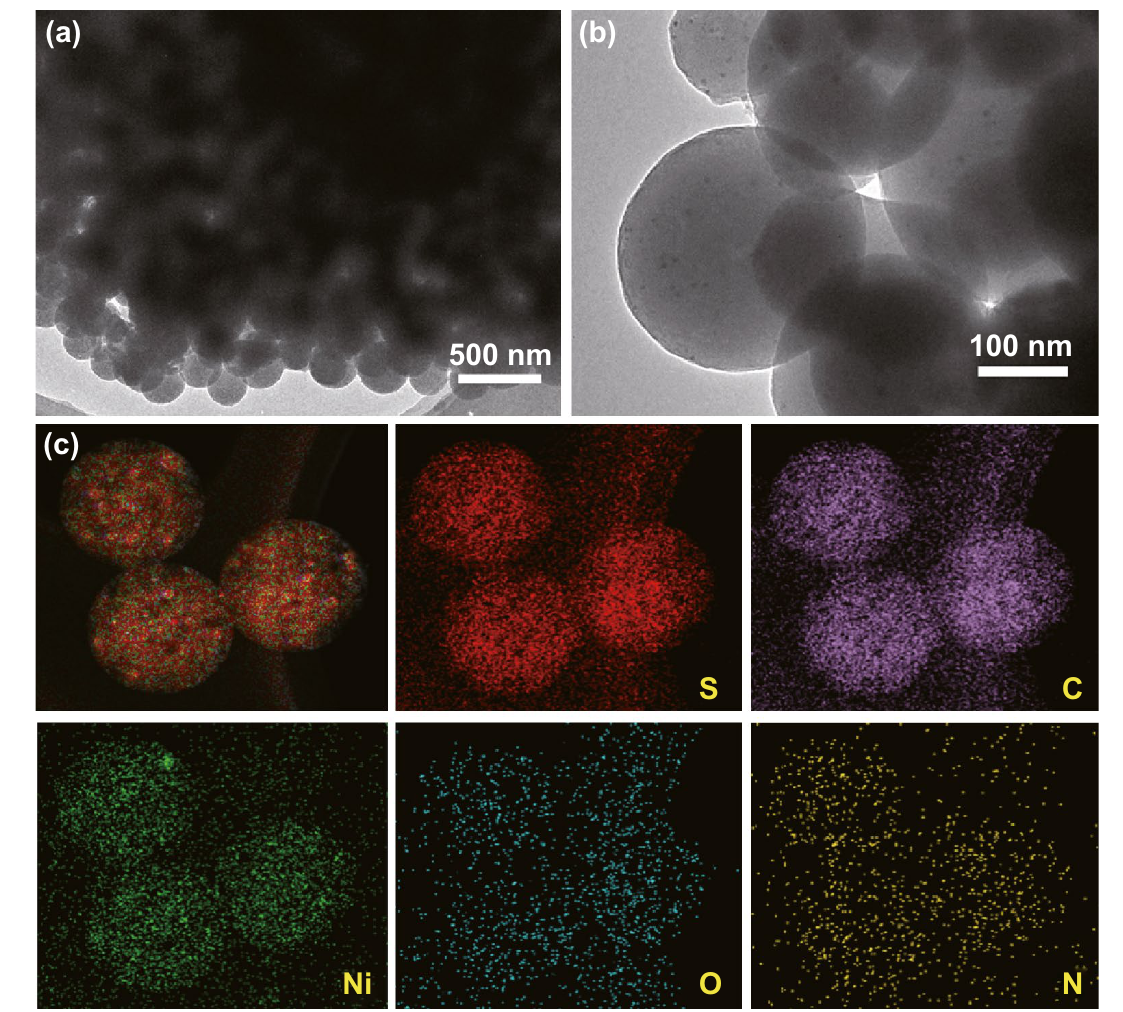
Fig. 5 a , b TEM images and c EDS elemental mapping images of